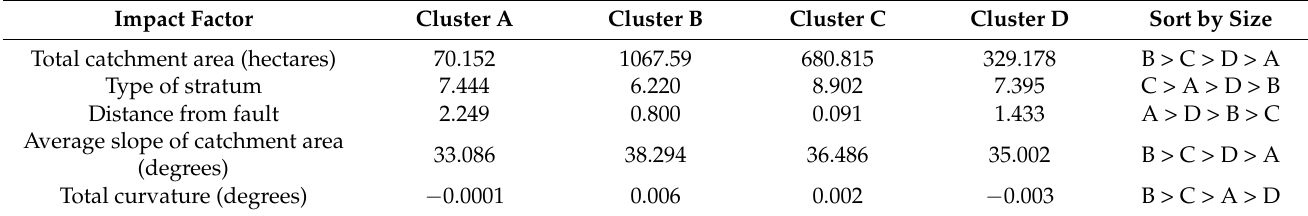
Table 20. K-means test for group